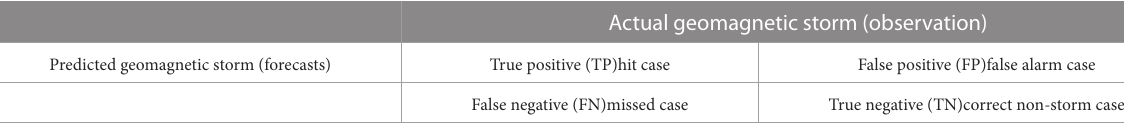
TABLE1 Confusionmatrixforbinaryclassificationofthegeomagneticstorm.